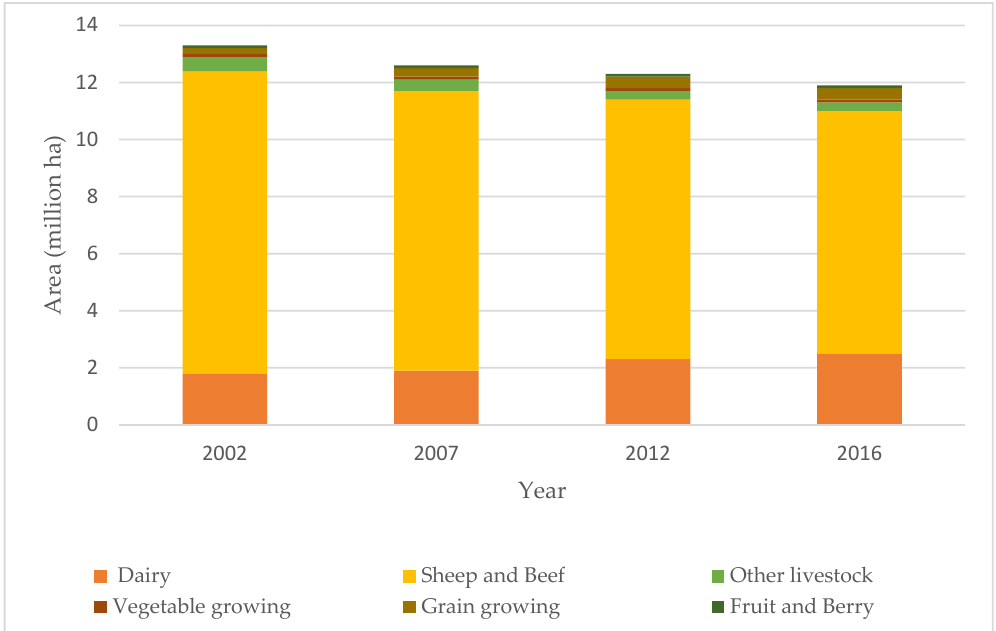
Figure 1. Area covered by main agricultural and horticultural land use types in NZ during 2002–2016 (This work is based on/includes Stats NZ’s data which are licensed by Stats NZ for reuse under the Creative Commons Attribution 4.0 International licence [23].